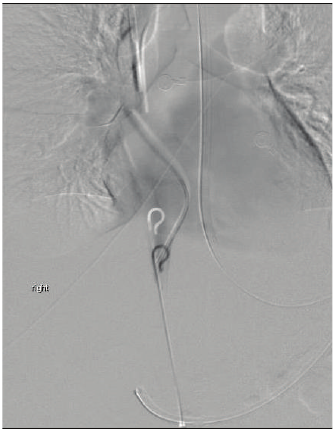
Figure 7: Another view of the catheter fragment retrieval proce-